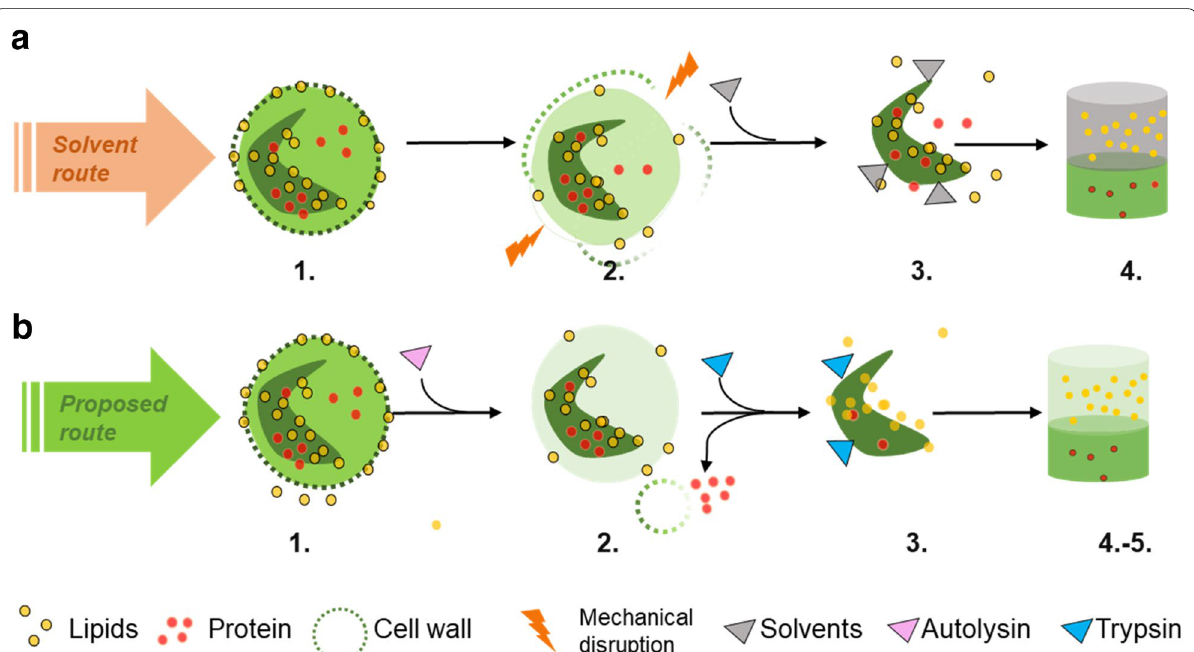
Fig. 1 a Lipid solvent extraction process: (1) harvesting, (2) cell permeabilization, (3) incubation with solvent, and (4) separation and recovery. b Proposed enzymatic process; (1) harvesting, (2) autolysin treatment, (3) incubation at 35 °C for prolonged time, (4) secondary enzymatic treatment, and (5)